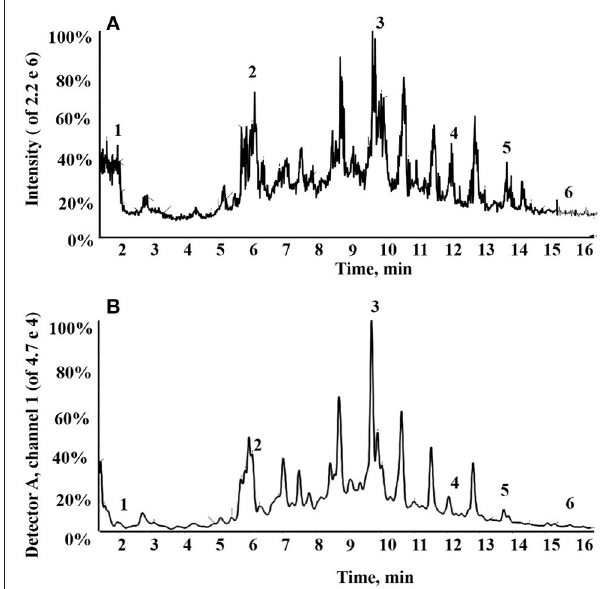
FIGURE 6 | Total ion chromatogram of the dichloromethane fraction of the Camellia nitidissima Chi flowers (A) ; HPLC chromatogram of the dichloromethane fraction by 360nm detection (B)